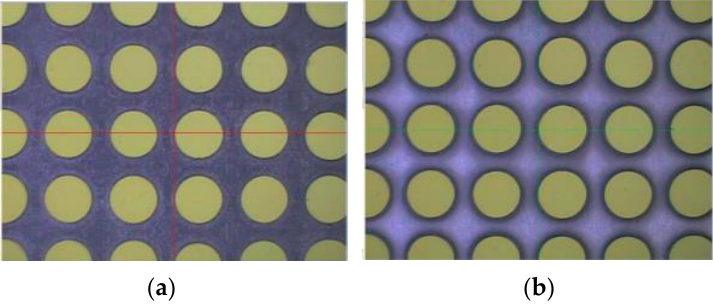
Figure 2. Picture taken by CCD camera. ( a ) shows the entry side of the hole (D in ) while ( b ) shows the exit side of the hole (D out ).